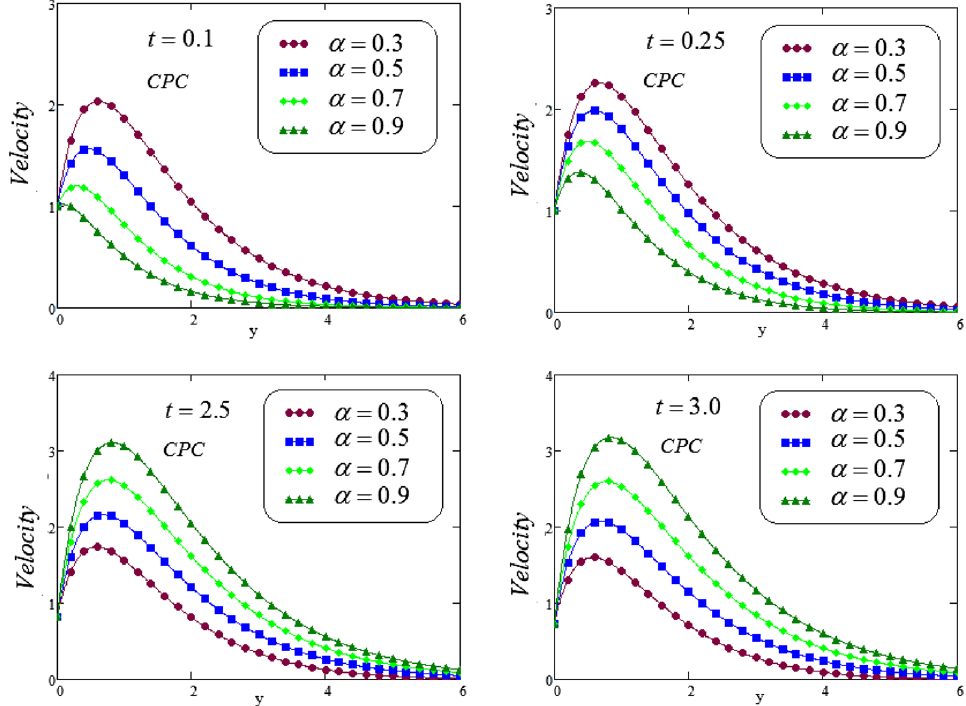
Figure 14. Trace of dimensionless velocity for CPC fractional operator for various values of α .